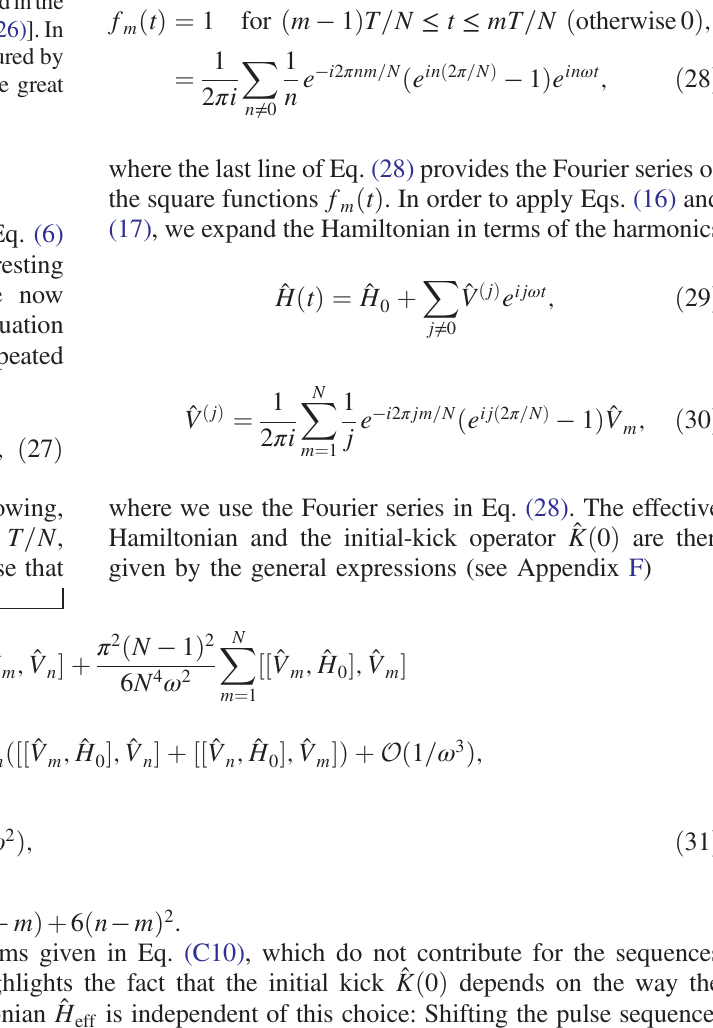
FIG. 1. Sensitivity to the initial phase of the driving. The brown curve represents the classical dynamics of a particle driven by a repeating pulse sequence fþ F; − F g , where F > 0 is a uniform force;theperiodis T ¼ 20 ,andtheparticleisinitiallyatrest v ð t i Þ ¼ 0 at x ð t 0 . The red curve is the same but considers the sequence i Þ ¼ f − F; þ F g , i.e., shifts the starting time t i → t i þ T= 2 . The blue curve is also the same but starts the sequencewith − F during a time T= 4 andthenrepeatsthesequence fþ F; − F g ,i.e.,shiftsthestarting → t − T= 4 .Notethattheinitialkick ˆ K ð t time t isinhibitedinthe i i i Þ latter case, while it is opposite in the two former cases [Eq. (26)]. In all the plots, the particle depicts a small micromotion, captured by ˆ K ð t Þ in Eq. (26). The brown and red curves highlight the great sensitivity to the initial phase of the modulation.